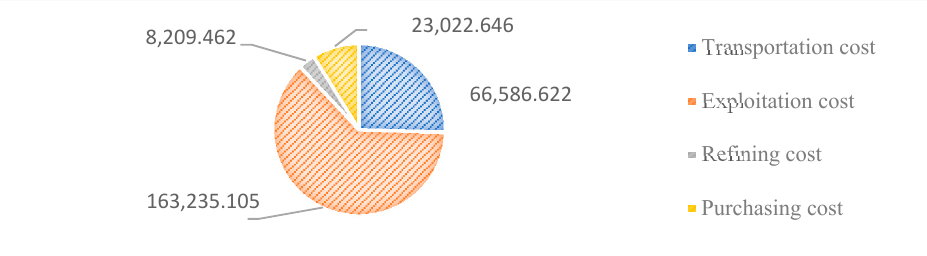
Figure 8. Variable cost structure.